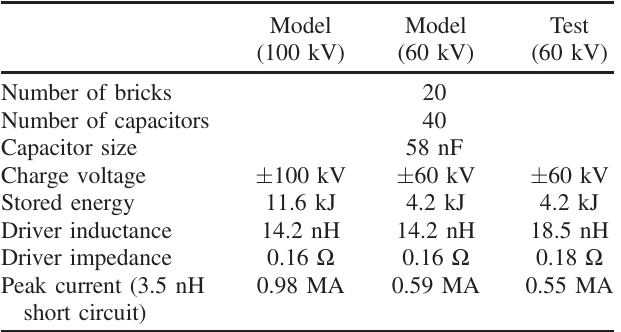
TABLE I. Comparison of nominal design parameters for the CESZAR machine with capacitors charged to (cid:1) 100 and (cid:1) 60 kV and results of the 3.5 nH short-circuit tests with capacitors charged to (cid:1) 60